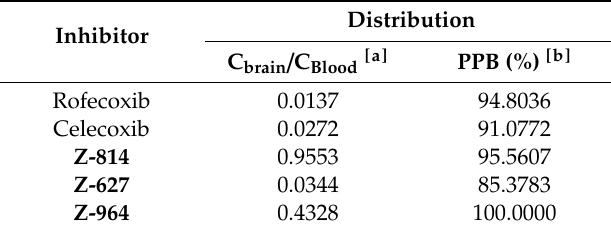
Table 8. Distribution data of selected inhibitors.